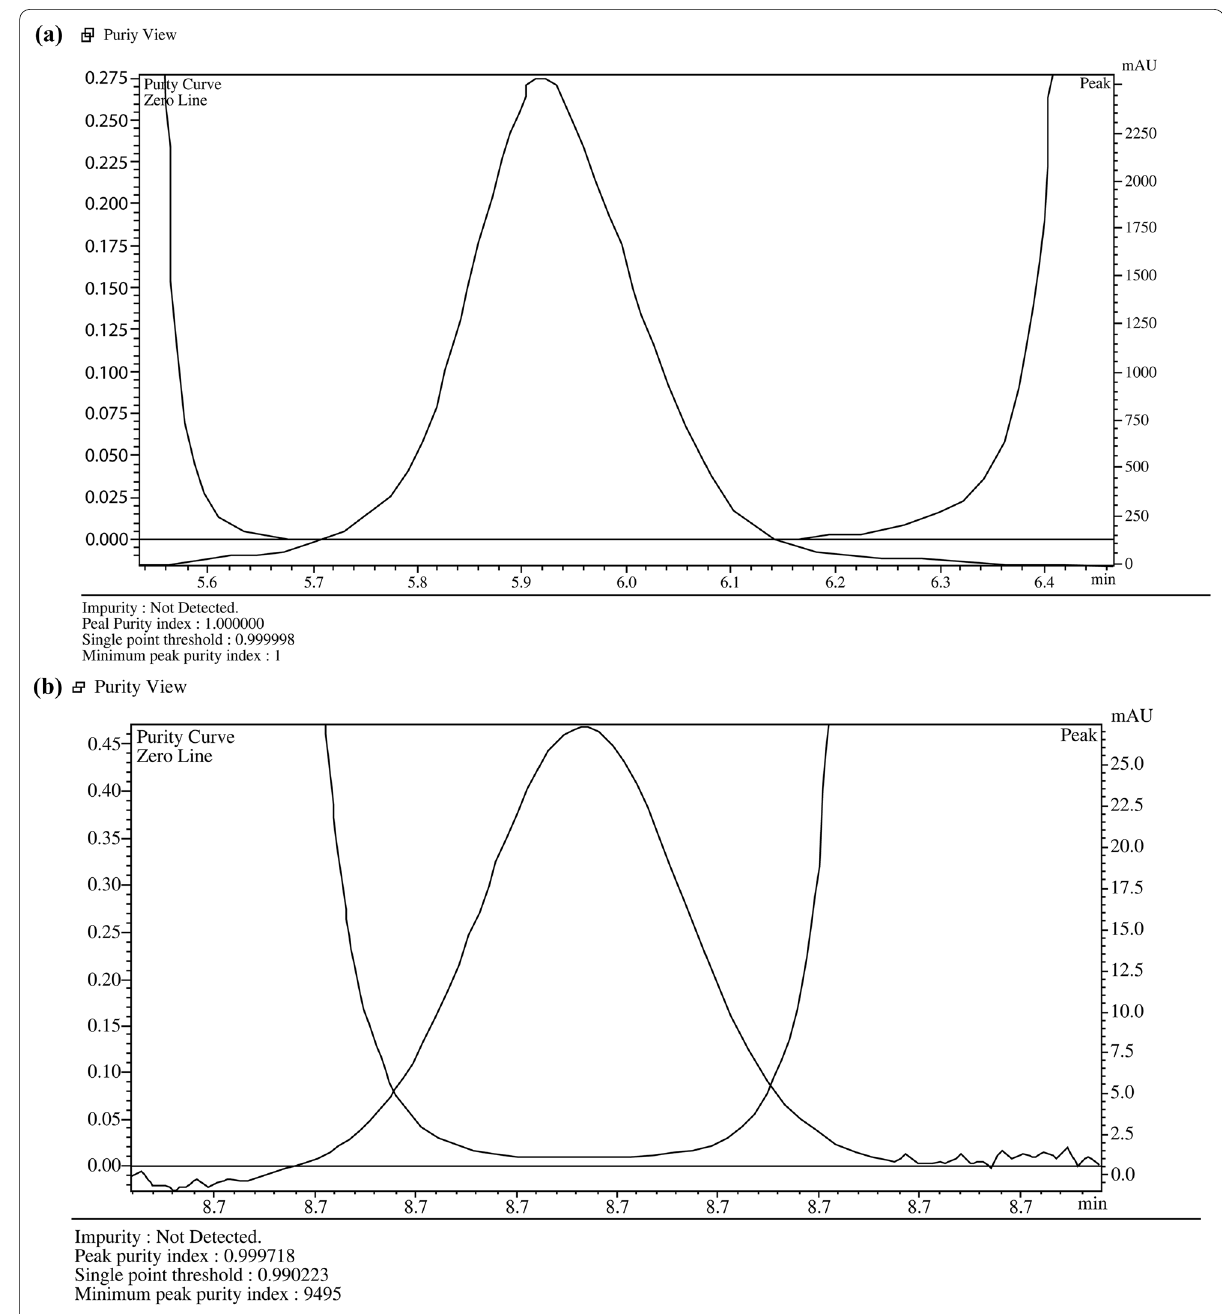
Fig. 6 Peak purity of assay sample, a peak purity curve for NAP and b peak purity curve for